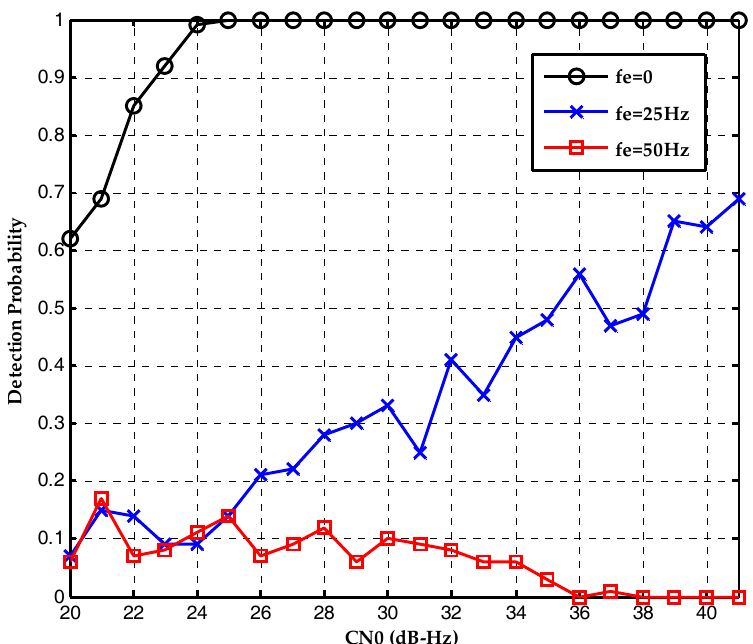
Figure 9. Detection probabilities of the ML bit synchronization algorithm under the CN0s of 20~40 dB-Hz and different frequency deviations.